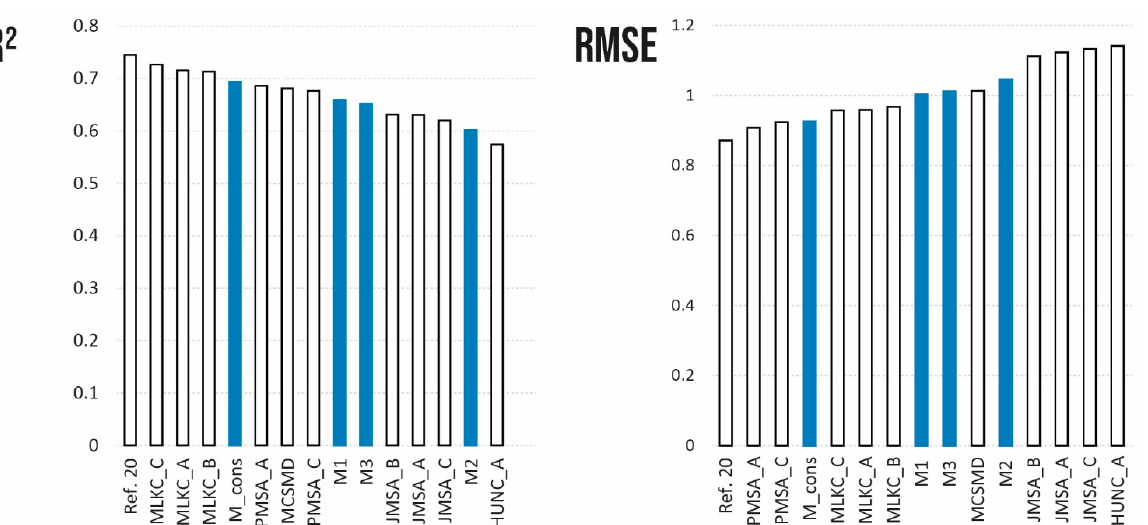
Figure 4. Comparison of Solubility Challenge 2019-submitted best models, consensus model (M_cons) published in this paper, and previously published RF model ([20]). Models from present study are marked as blue.